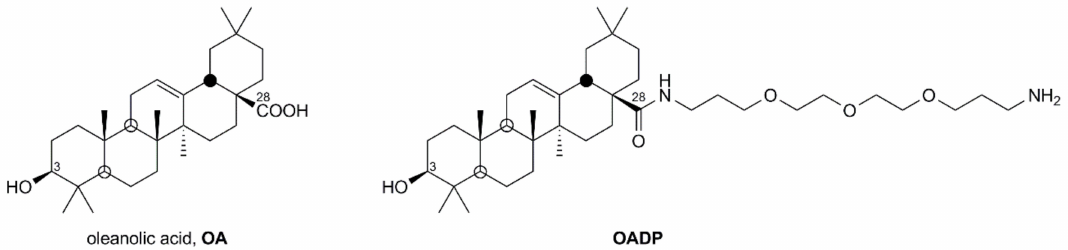
Figure 12. Structures of triterpene compounds OA and OADP